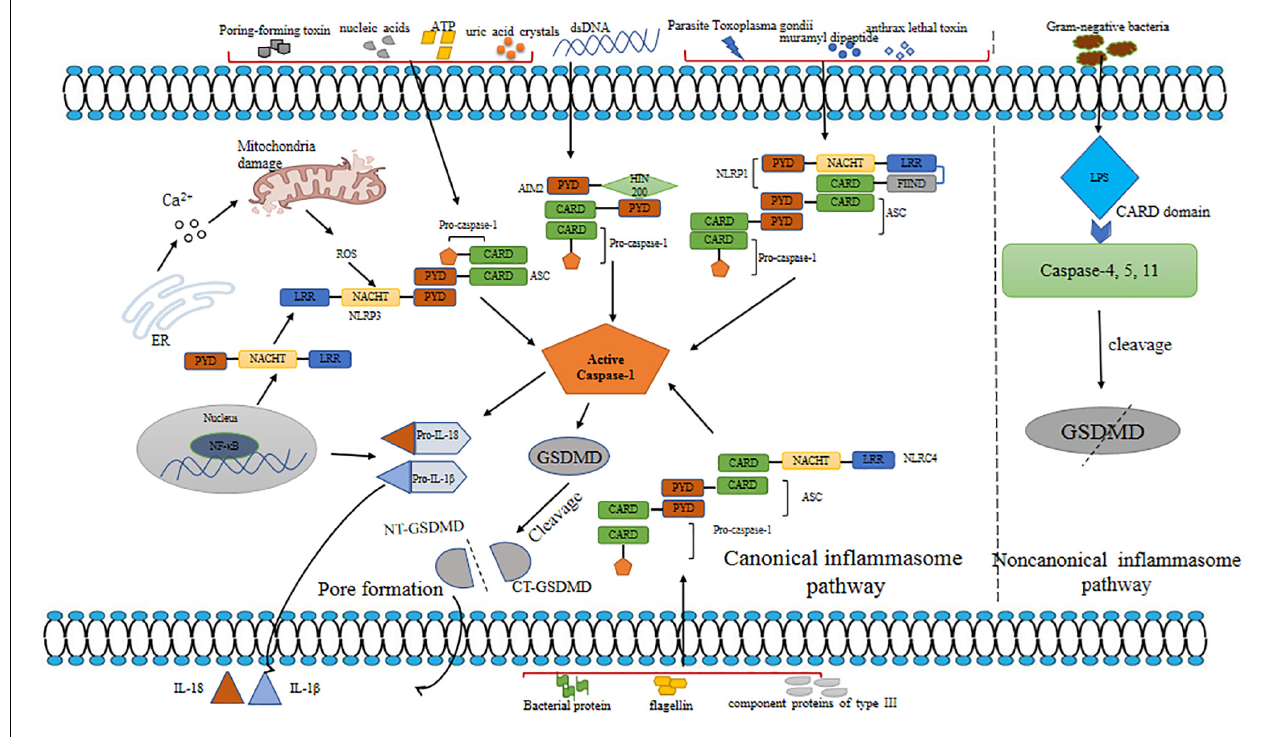
FIGURE 2 | Mechanisms of pyroptosis. Pyroptosis is triggered by canonical and non-canonical inflammasome pathways. Various inflammasomes involved in canonical pathway are activated by different DAMPs and PAMPs. Canonical inflammasomes bind to ASC to activate caspsase-1. Caspase-1 plays a role in maturation of IL-1 β and IL-18 and cleavage of GSDMD. N-GSDMD releases and forms a membrane pore, leading to the secretion of IL-1 β and IL-18. In non-canonical pathway, LPS binds to human caspase-4/5 and mice caspase-11 to promote cleavage of GSDMD. dsDNA, double-stranded DNA; ROS, reactive oxygen species; AIM2, absent in melanoma 2; ASC, apoptosis-associated speck-like protein containing a caspase recruitment domain; NLRP3, NOD-like receptor; PYD, pyrin domain; LRR, leucine-rich repeat; NACHT, nucleotide binding and oligomerization; HIN-200, the interferon (IFN)-inducible p200-protein; GSDMD, gasdermin D; NT-GSDMD, N-terminal gasdermin D; CT-GSDMD, C-terminal gasdermin D; LPS; lipopolysaccharide; DAMPs, danger-associated molecular patterns; PAMPs, pathogen-associated molecular patterns; IL-18, interleukin-18; IL-1 β , interleukin-1 β